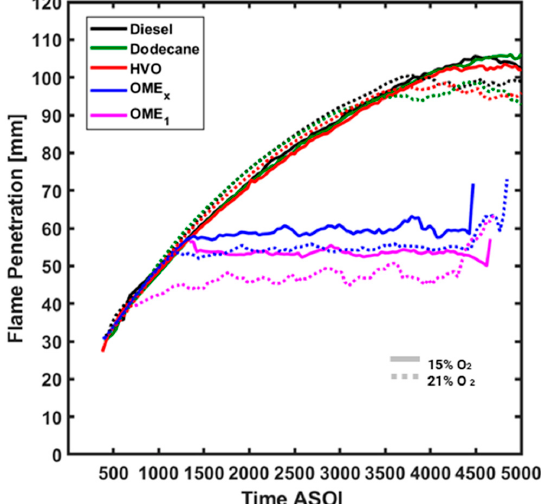
Figure 9. Flame penetration at 900 K and 1500 bar. The solid lines correspond to 15% of Oxygen and dotted lines to 21%.